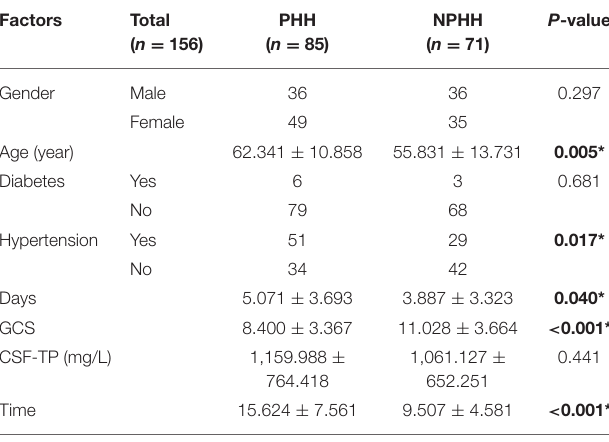
TABLE 1 | Univariate analysis of the association between potential risk factors and posthemorrhagic hydrocephalus (PHH). Factors